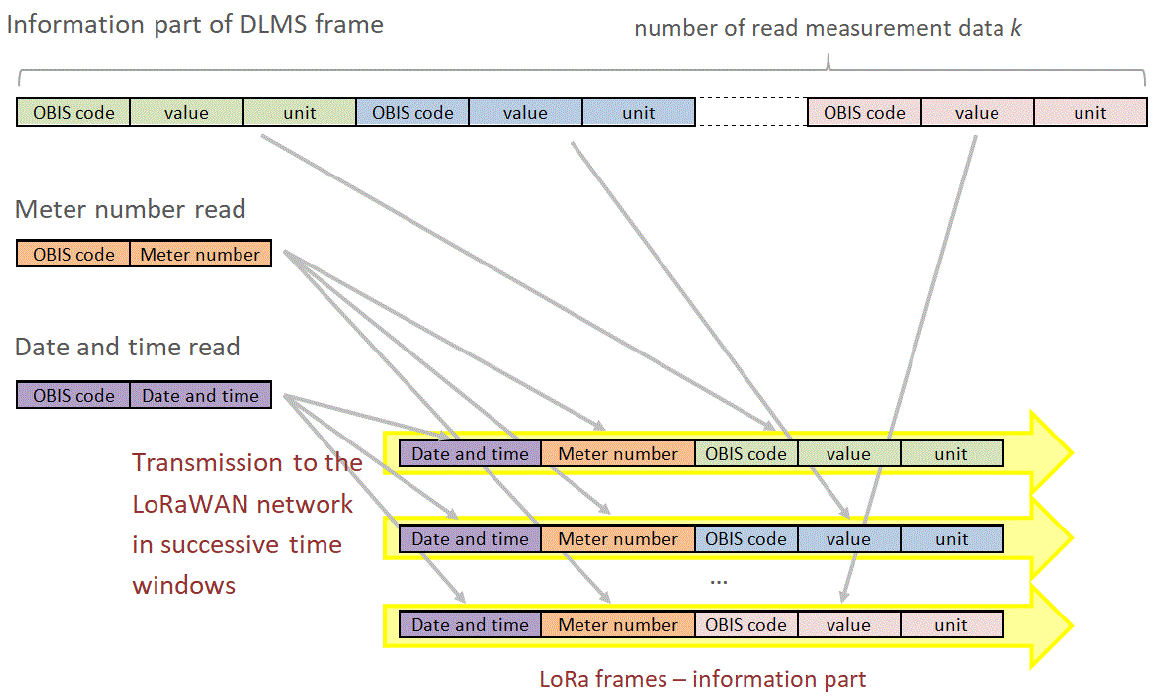
Figure 2. Processing of the DLMS frame information part with measurement data into corresponding LoRaWAN frames.